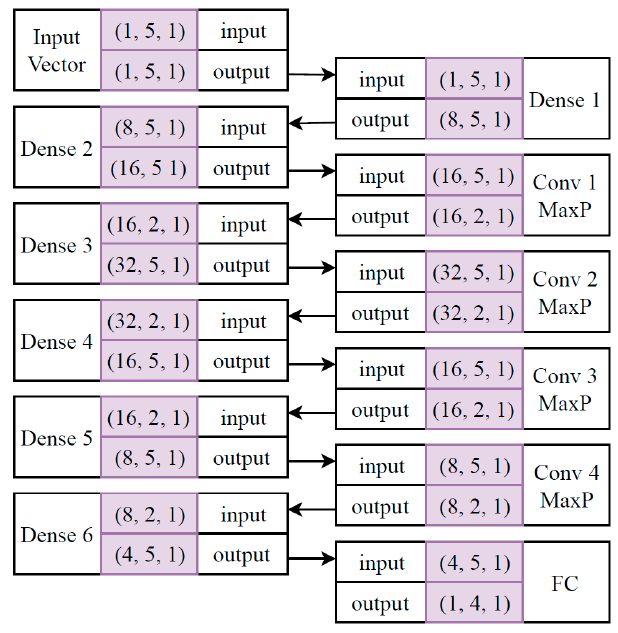
Figure 3. Proposed convolutional neural network (CNN) architecture for the ATRP.